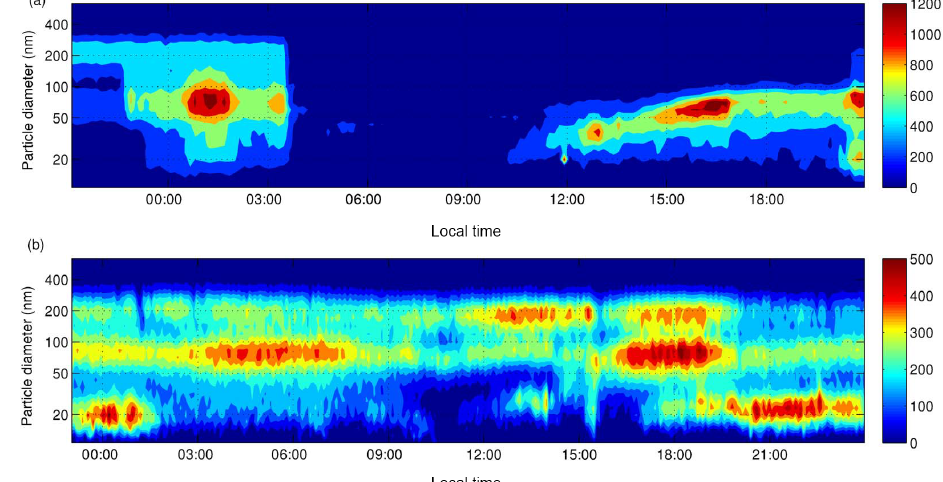
Figure 7. (a) Example of a new particle formation (NPF) and growth event starting on 21 February 2014 10:00LT. (b) Example of undefined events, on 4 June 2009. Particle bursts were observed at 00:00, 14:00 and 21:00LT, without subsequent growth. In both plots, the color coding shows the particle number concentration normalized by diameter channel, d N/ dlog D p , in cm − 3 .